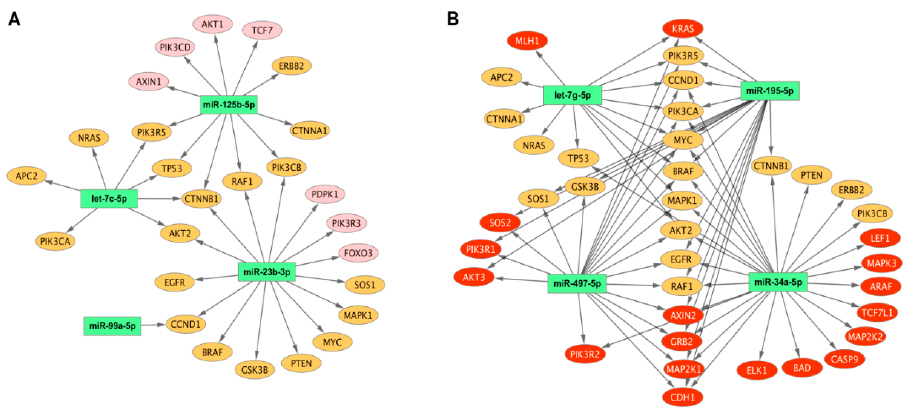
Figure 3. MicroRNA–target gene network for discriminating miRNAs. MicroRNA–target gene network for miRNAs discriminating grade 1 from grade 3 ( A ) and endometrioid from serous endometrial carcinoma ( B ). Target genes regulated by miRNAs discriminating between different grades in endometrioid and endometrioid and serous carcinoma are depicted in pink and red, respectively. Target genes regulated by miRNAs from both sets are depicted in orange. The associations between microRNAs and target genes are represented by black arrows. The scheme was generated by CytoScape 3.8.0.